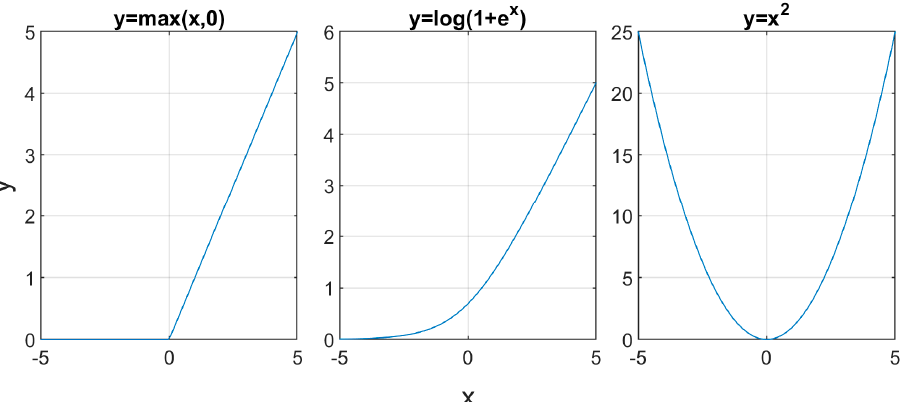
Figure 1. Activation functions preserving solution non-negativity. From left to right: ReLU, Softplus, and Square functions.